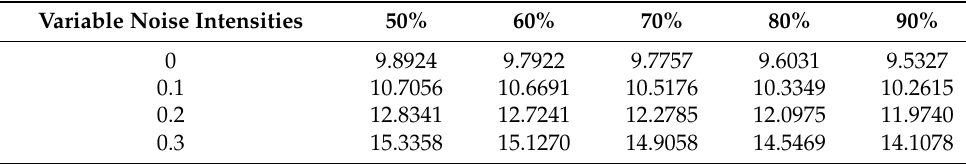
Table 4. The RMSE (K) of the IASR-CNN method with different usage ratios. Variable Noise Intensities